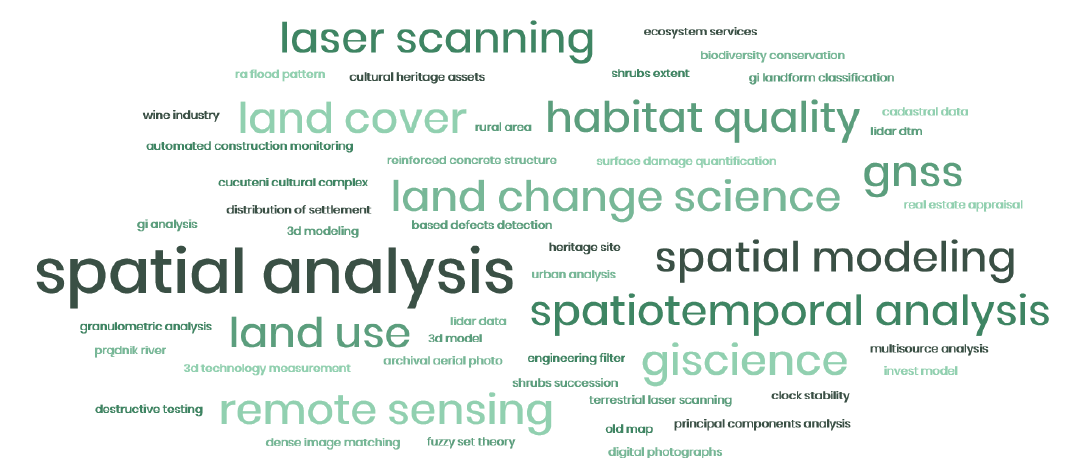
Figure 1. A word cloud generated from 20 publications published in the Special Issue on Remote Sensing and GIS for Environmental Analysis and Cultural Heritage in Remote Sensing.